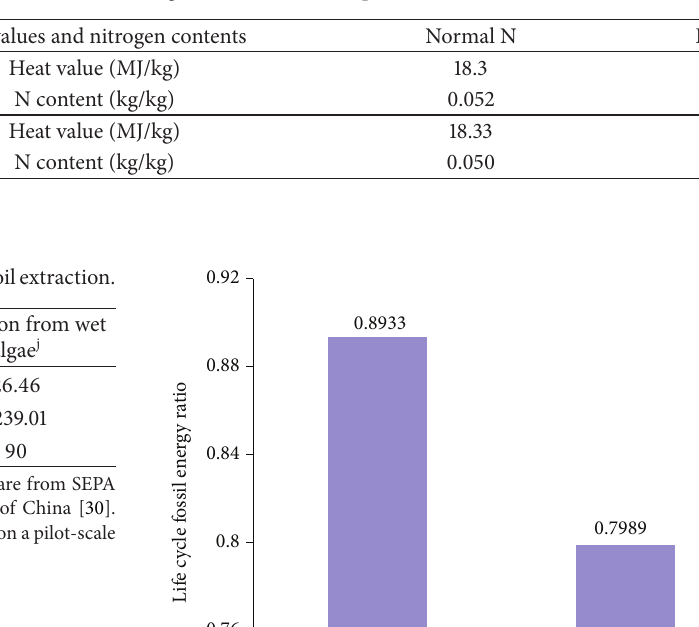
Table 3: Net calorific values of algae and N fertilizer inputs.